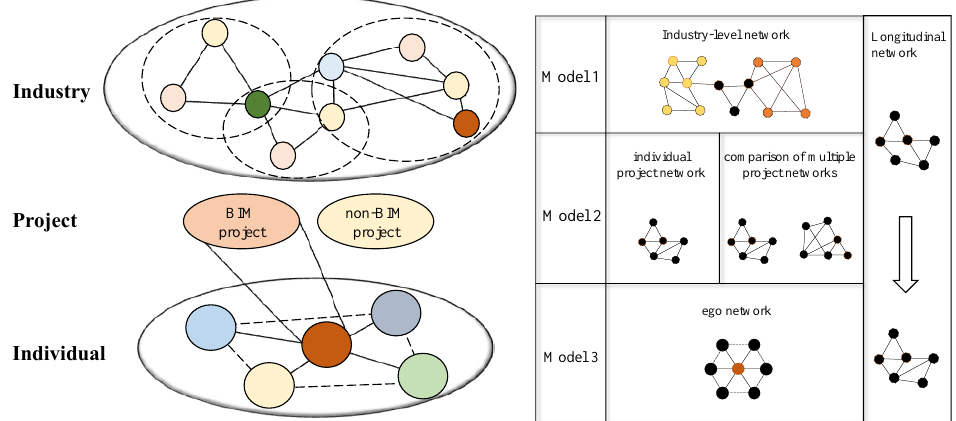
Figure 4. Framework of network models for CPM research.